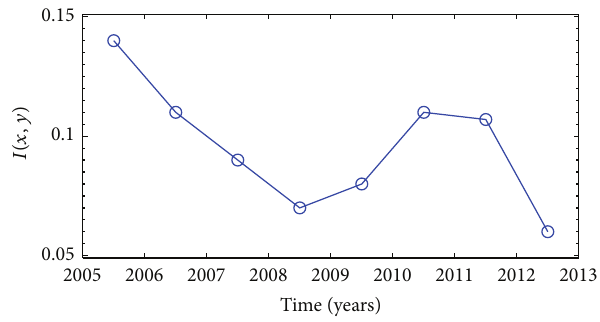
Figure 3: Mutual information of links between a network of the Chinese interbank market estimated at year 𝑡 and the network estimated at the year 𝑡 + 1 .